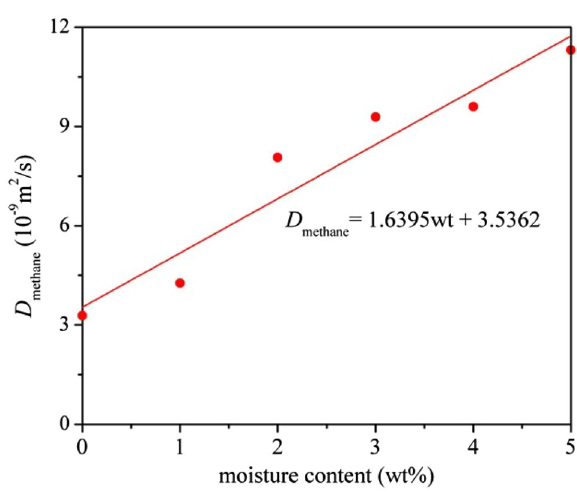
Fig. 5 The CH 4 self-diffusion coefficients as a function of water content